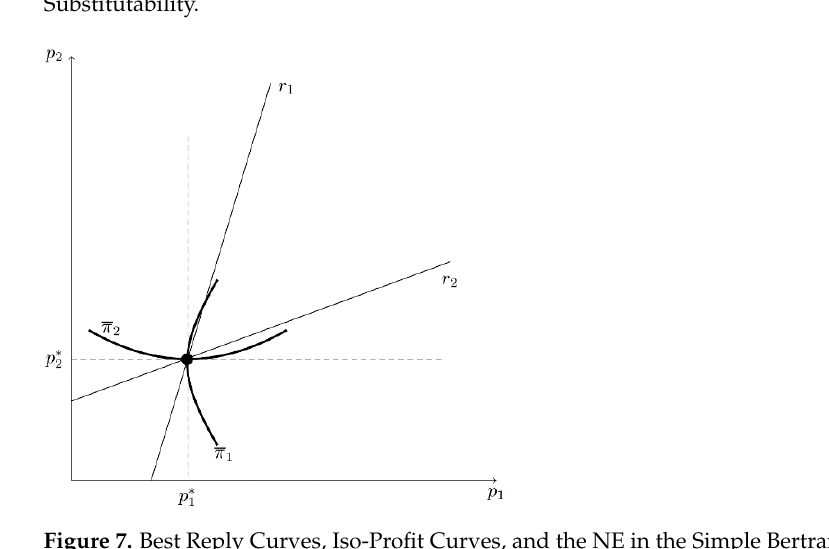
Figure 7. Best Reply Curves, Iso ‐ Profit Curves, and the NE in the Simple Bertrand Model.